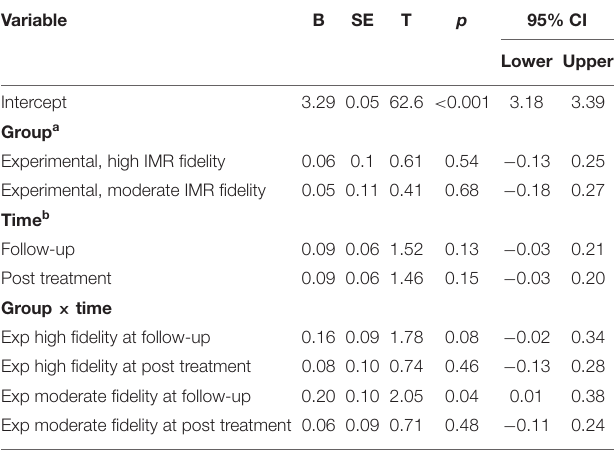
TABLE 4 | Fixed coefficients for linear mixed model (IMR client version) on time effects for high and moderate IMR fidelity. Variable